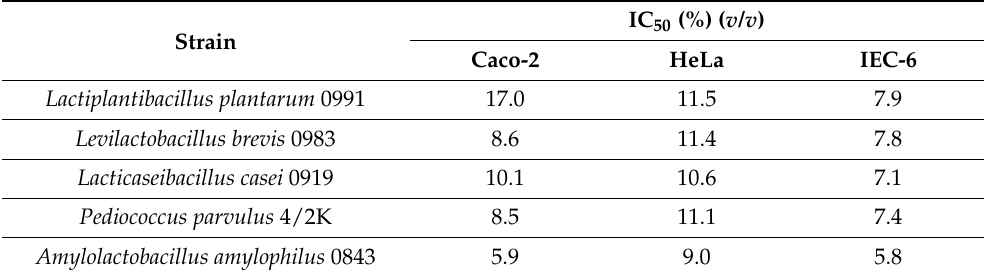
Table 3. IC 50 (%) values of post-fermentation media (PFM) determined for five selected lactic acid bacteria (LAB)